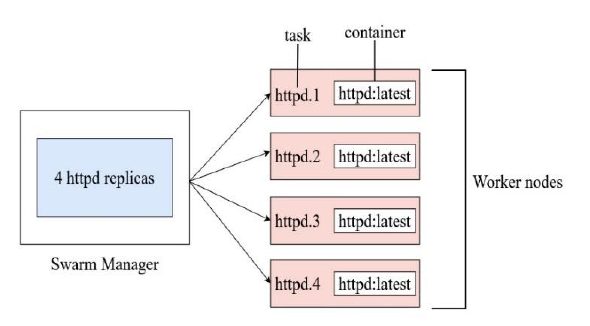
Figure 2. Docker